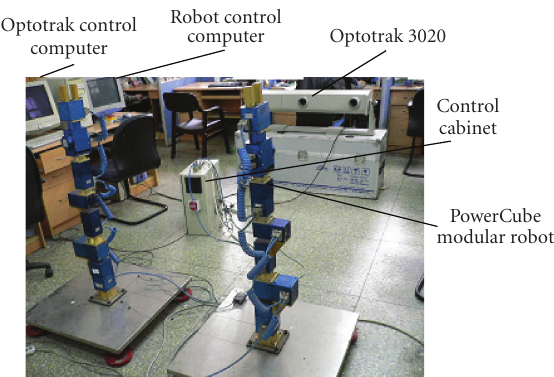
Figure 1: The system configuration of the cooperative modular robot system.